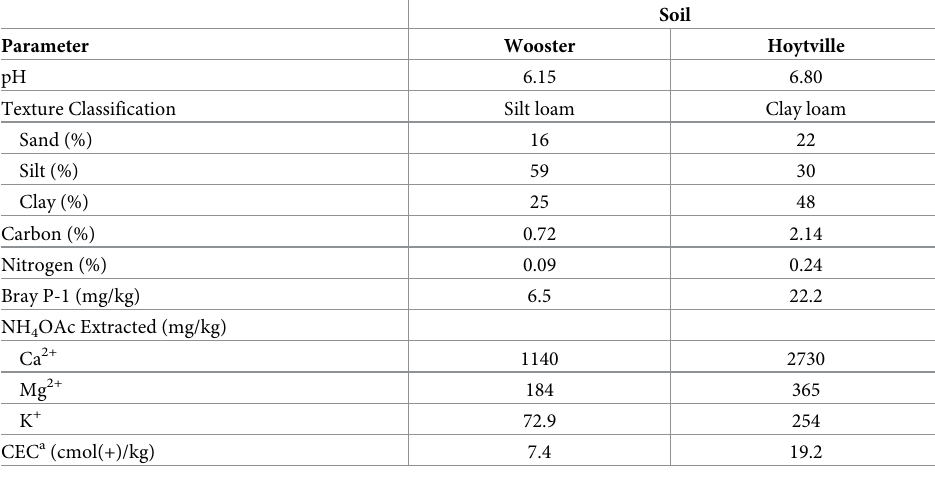
Table 1. Soil chemical characteristics (Adapted from [46,